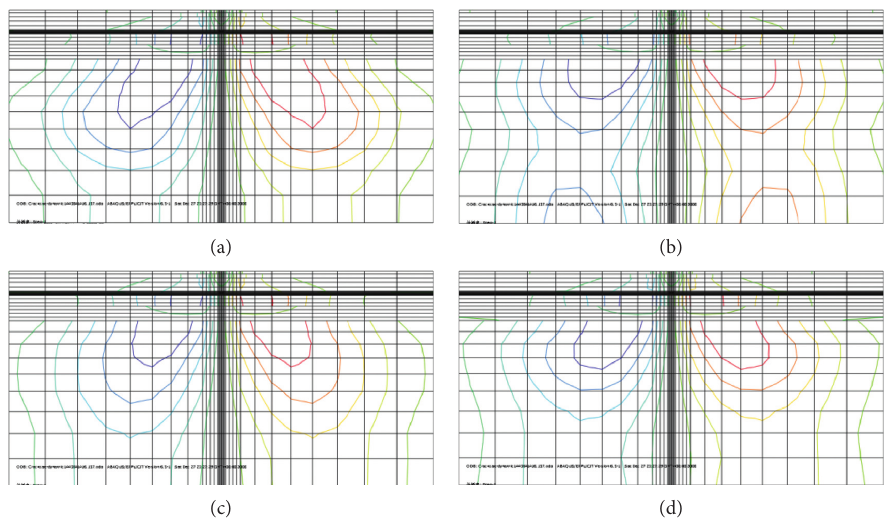
Figure 19: Vertical strain. (a) t � 1/8, (b) t � 2/8, (c) t � 3/8, and (d) t �